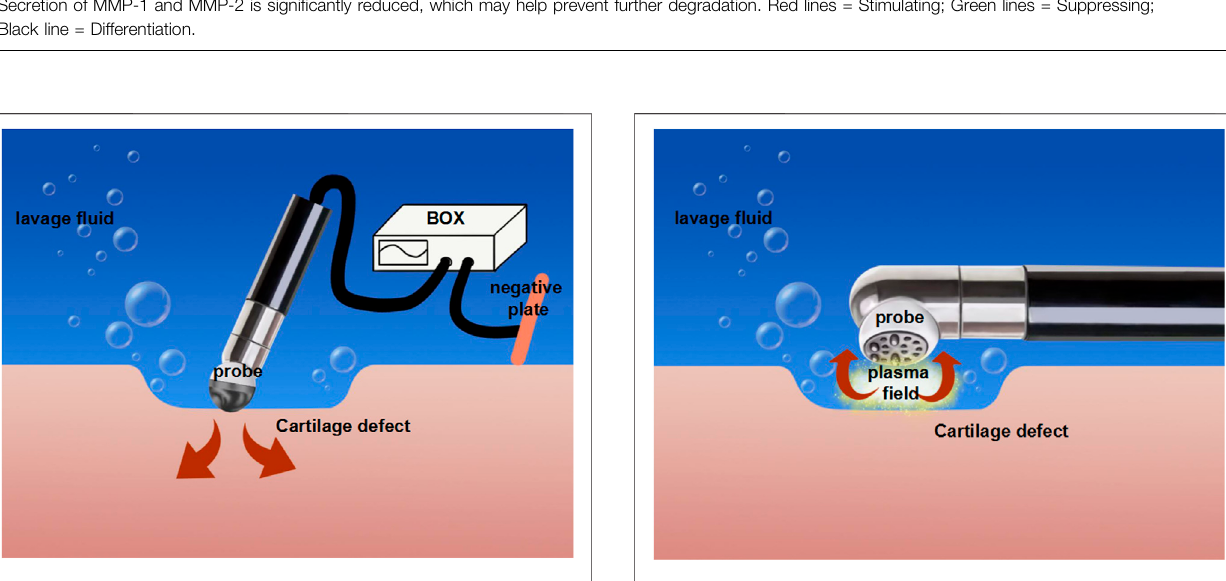
FIGURE2| Themechanismofmonopolarradiofrequencyenergy(mRFE). FIGURE 3 | The mechanism of bipolar radiofrequency energy